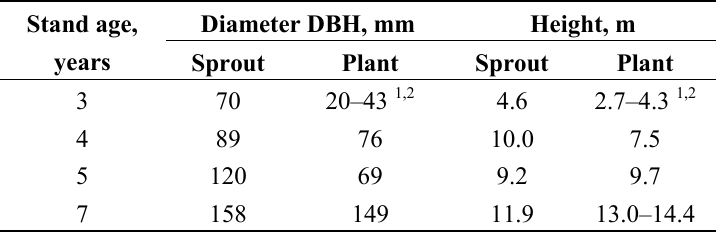
Table 9. Diameters (mm) and heights (m) for 4–8 year-old dominant sprouts and plants. Diameter DBH, mm Height, m Stand age, years Sprout Plant Sprout Plant 3 70 20–43